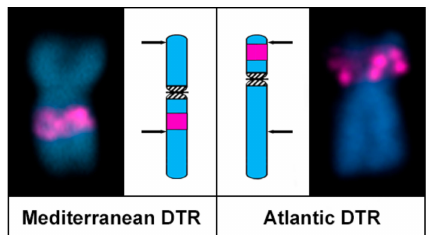
Figure 5. Ideogrammatic representation of the pericentric inversion differentiating chromosome 6 in Mediterranean and Atlantic populations of Donax trunculus . Arrows point to inversion